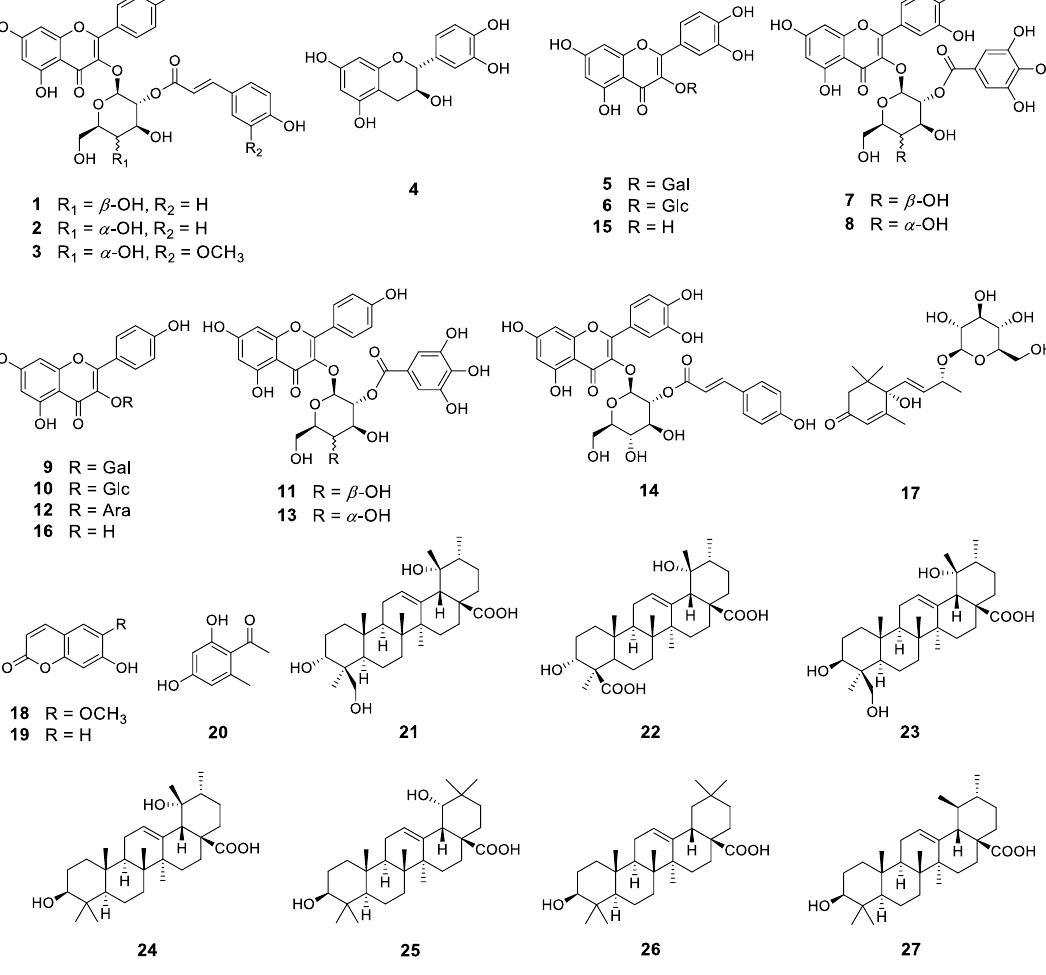
Figure 2. Structures of the compounds isolated from D. kaki